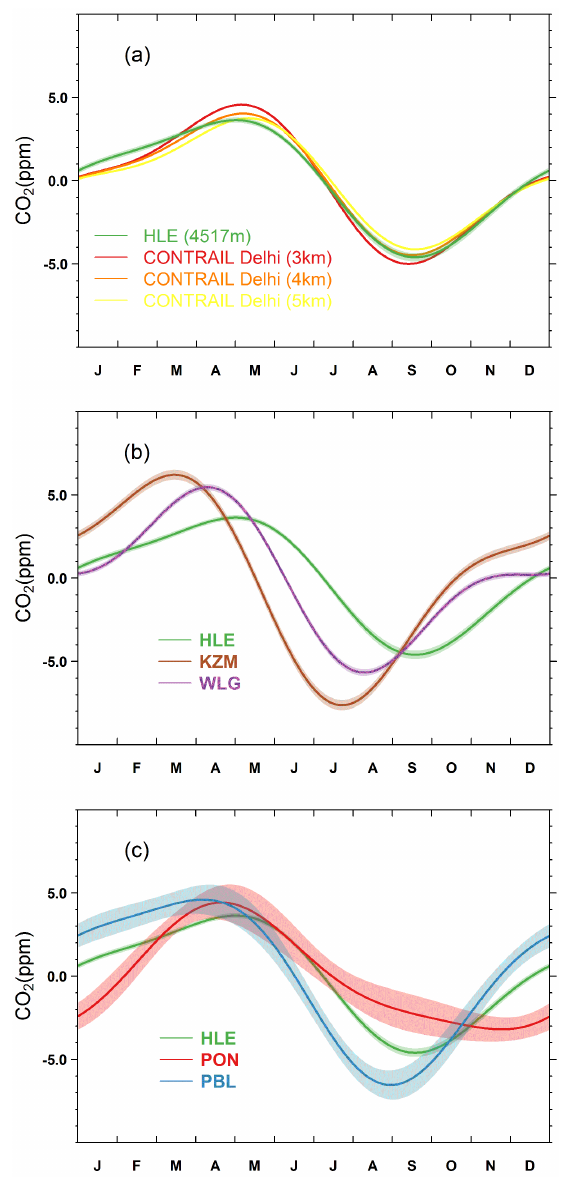
Figure 3. (a) The mean CO 2 seasonal cycle at HLE, in compar- ison with the mean seasonal cycles derived from the in situ CO 2 measurements over New Delhi at different altitude bands (3–4, 4– 5, and 5–6km) by the CONTRAIL project (2006–2010). (b) The mean CO 2 seasonal cycles at HLE, KZM and WLG. (c) The mean CO 2 seasonal cycles at HLE, PON and PBL. For each station, the mean seasonal cycle is derived from the harmonics of the smoothed fitting curve in Fig. 2. Shaded area indicates the uncertainty of the mean seasonal cycle calculated from 1 SD of 1000 bootstrap repli- cates. For the CONTRAIL data sets, CO 2 measurements over New Delhi were first averaged by altitude bands. A fitting procedure was then applied to the aggregated CO 2 measurements to generate the mean season cycle for different altitude